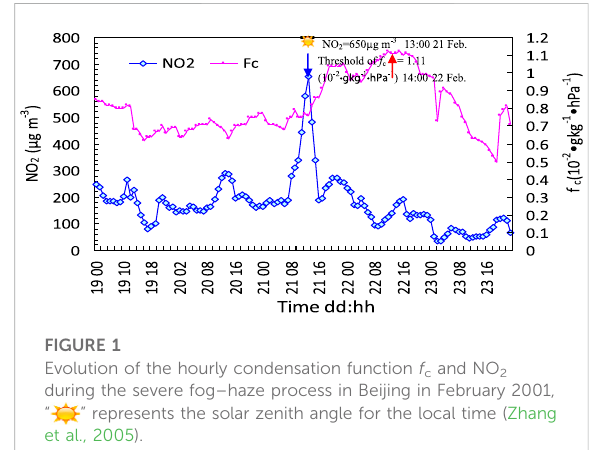
FIGURE 1 Evolution of the hourly condensation function f c and NO 2 during the severe fog – haze process in Beijing in February 2001, “ ” represents the solar zenith angle for the local time (Zhang et al.,